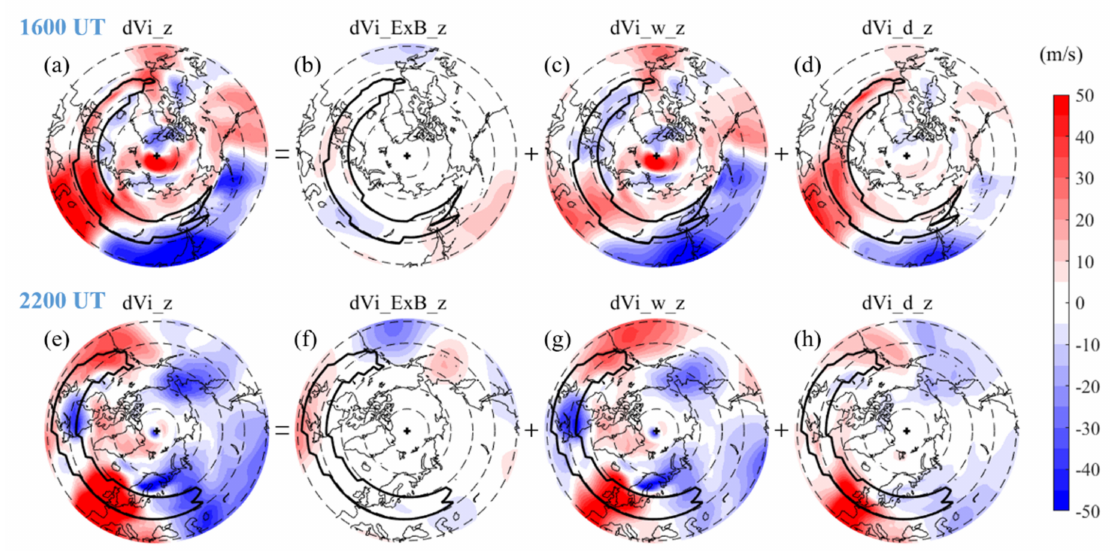
Figure 4. SAPS-induced vertical ion velocities due to ( a , e ) the combined effects of electric fields, neu- tral wind and ambipolar diffusion, ( b , f ) only electric fields, ( c , g ) neutral winds, and ( d , h ) ambipolar diffusion at 1600 ( upper panels ) and 2200 UT ( bottom panels